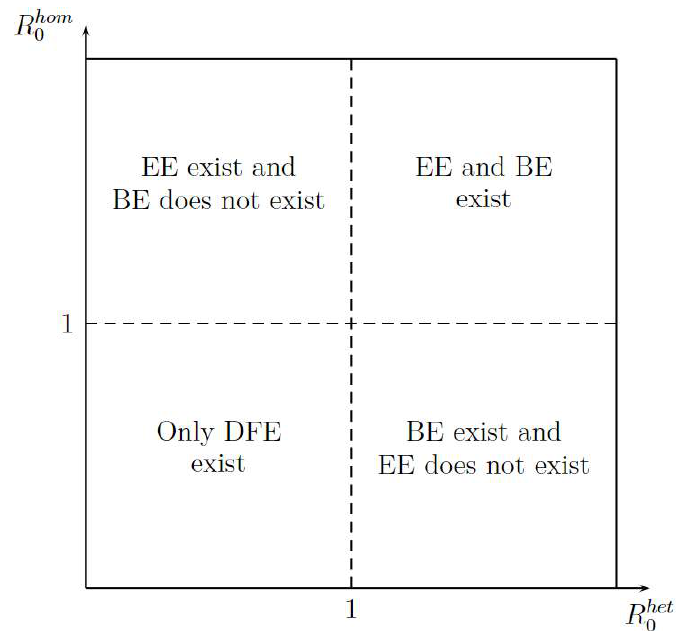
Figure 3. Stationary Points